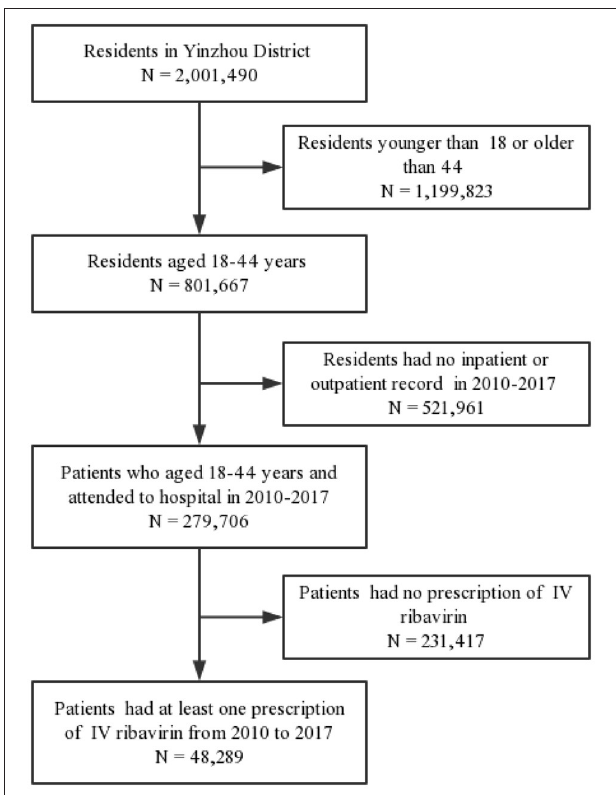
FIGURE 1 | Flowchart of identifying patients who ever used IV